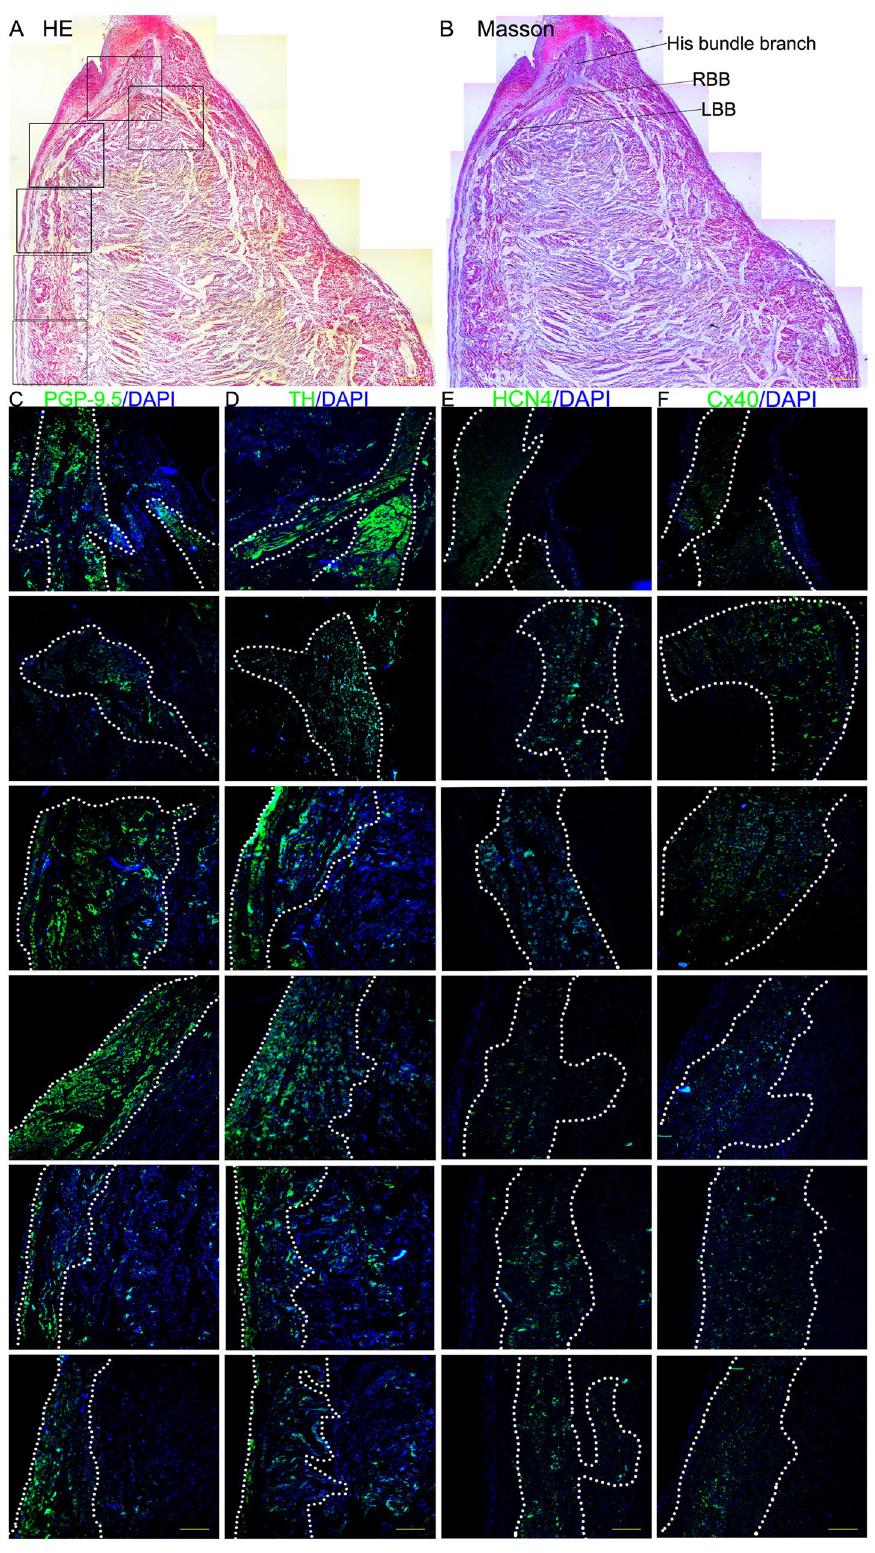
Figure 3. The results of the histological and immunofluorescence examination of the HBB and RBB. ( A ) HE staining (scale bar = 1200 μ m). ( B ) Masson staining (scale bar = 1200 μ m). ( C ) Immunofluorescence staining with the anti-PGP9.5 antibody. ( D ) Immunofluorescence staining with the anti-TH antibody. ( E ) Immunofluorescence staining with the anti-Cx40 antibody. ( F ) Immunofluorescence staining with the anti- HCN4 antibody. In C–F , the green region is the positive area, and the cell nuclei are stained with DAPI, scale bar = 400 μ